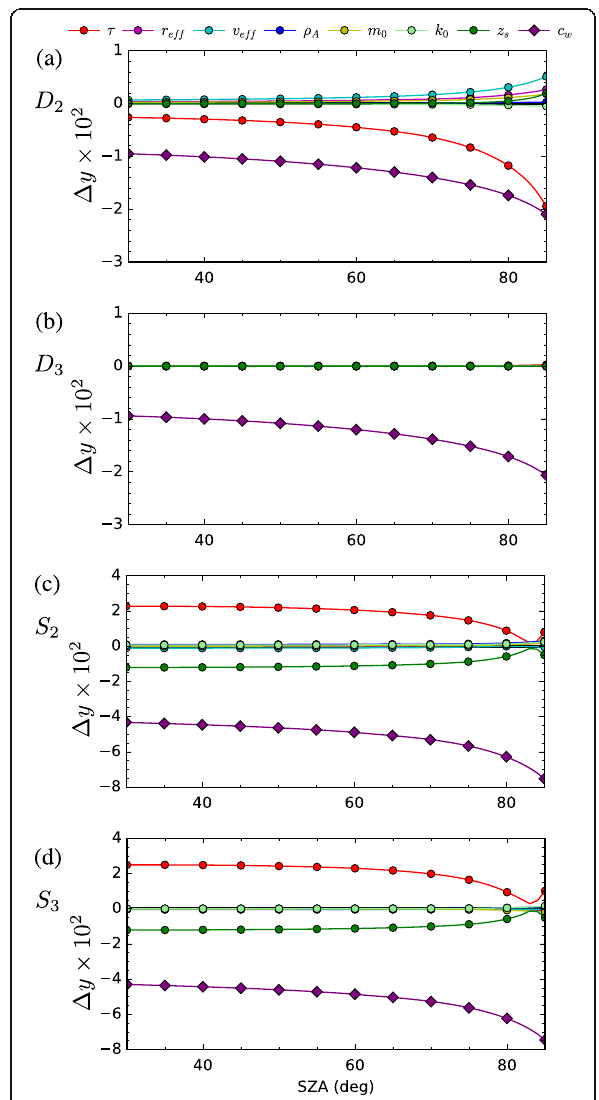
Fig. 12 Sensitivities of water vapor observation parameters to TCWV and dust model parameters. Panels ( a ) - ( d ) show the relation between Δ y ( c w ) and SZA for D 2 , D 3 , S 2 , and S 3 , respectively